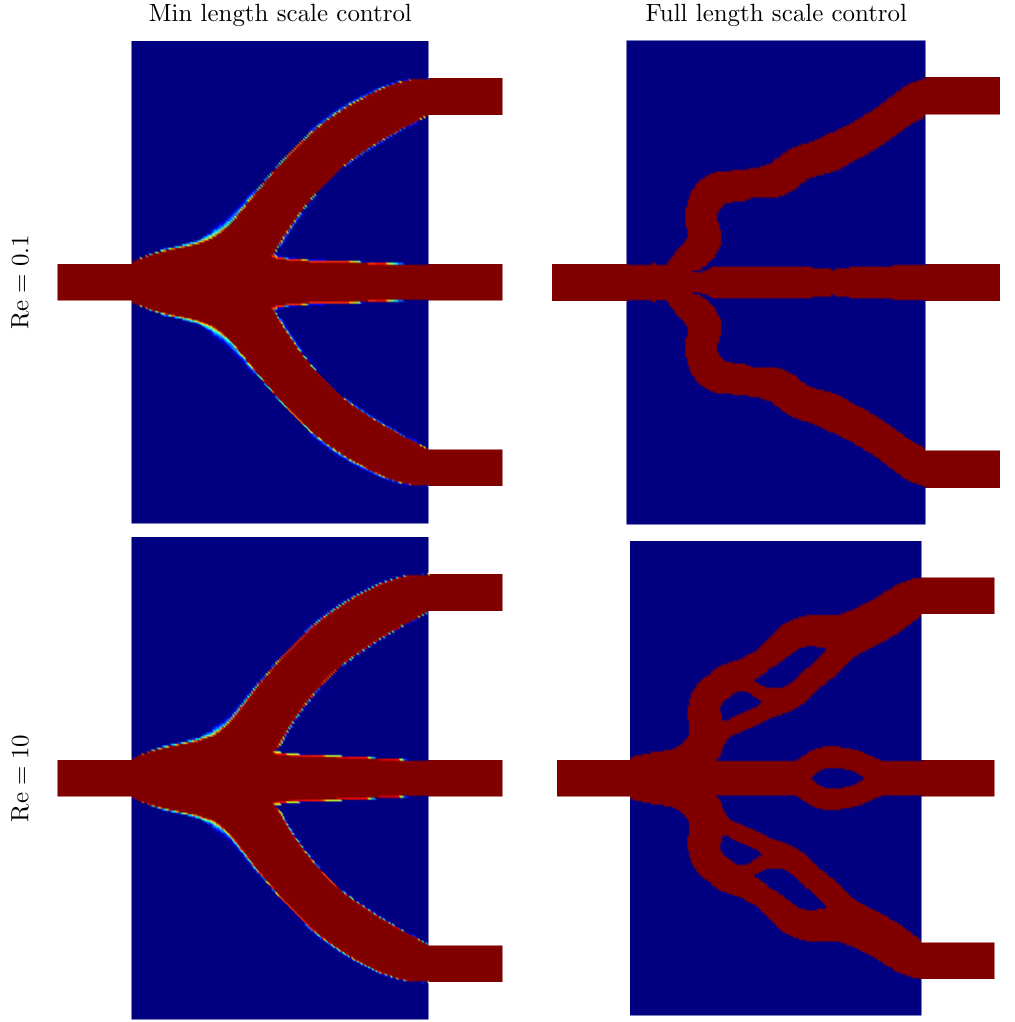
Figure 11. Optimized designs with aim to obtain equivalent outlet flowrate.